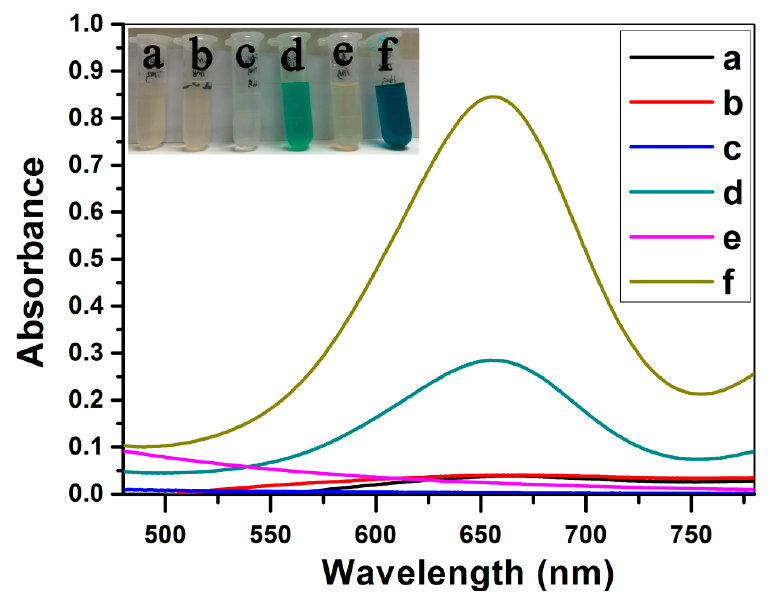
Figure 8. The UV-vis spectra of LNPs + TMB (a); LNPs + TMB + H 2 O 2 (b); Fe 3 O 4 + TMB (c); Fe 3 O 4 + TMB + H 2 O 2 (d); Fe 3 O 4 @LNPs + TMB (e) and Fe 3 O 4 @LNPs + TMB+ H 2 O 2 (f); Insert is the photograph of the corresponding solution.